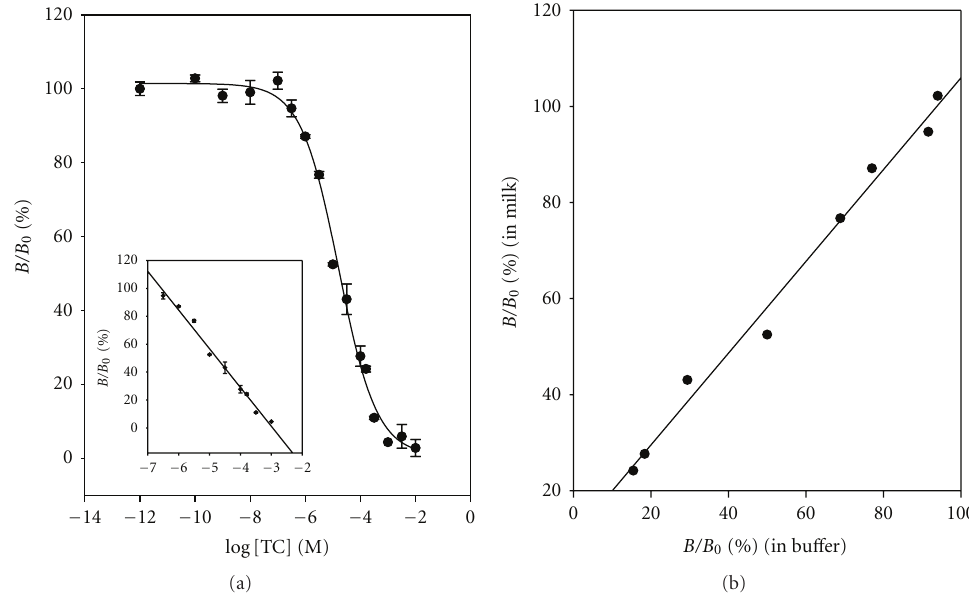
Figure 5: (a) Dose-response curve and calibration curve (inset) for TC in milk. % B/B 0 = − 27 . 7749 × log [TC] − 82 . 1902, R 2 = 0 . 9881. (b) Correlation diagram of B/B 0 for TC both in bu ff er and in milk. % B/B 0 (in milk) = 0 . 9550 × % B/B 0 (in bu ff er) − 10 . 4243, R 2 = 0 .